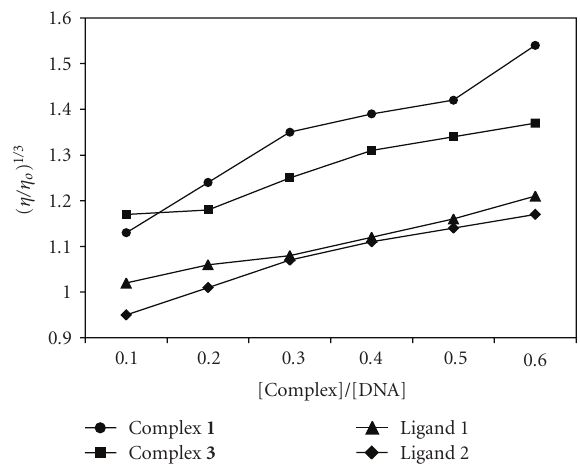
Figure 6: E ff ect of increasing amounts of complexes ( 1 and 3 ) and ligands on the relative viscosity of CT-DNA at 25 ± 0.1 ◦ C.